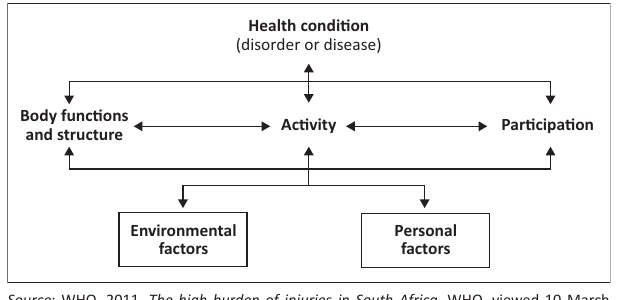
FIGURE 1: International classification of function and disability